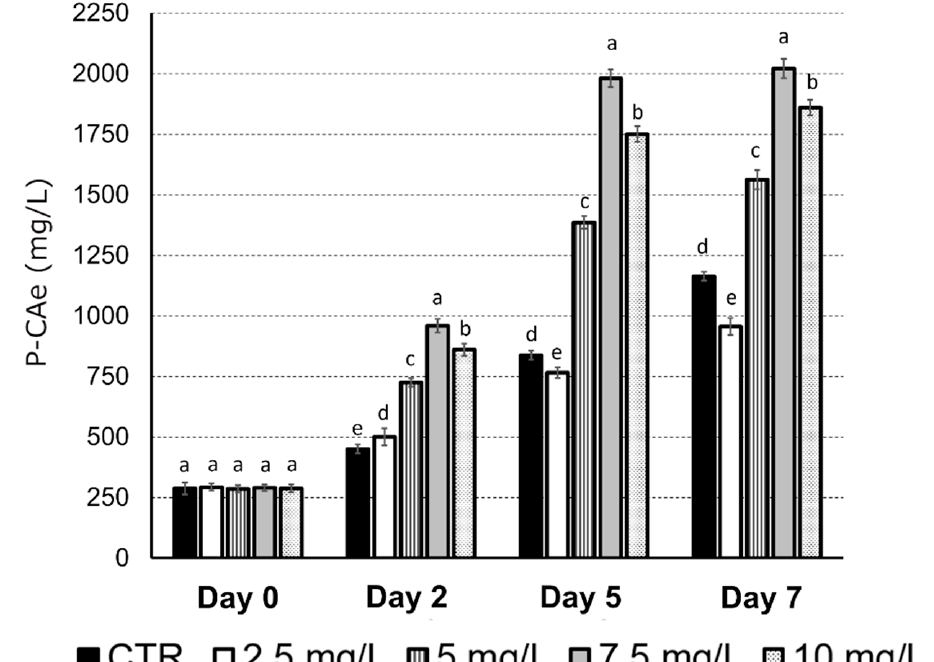
Figure 1. Content of total polyphenols, expressed as chicoric acid equivalent (P-CAe) after the addition of methyl jasmonate (MeJa) at different concentrations (2.5, 5, 7.5 and 10 mg/L) for 0, 2, 5 or 7 days. Data are mean ± SE for three biological replicates. Different letters above the bars indicate statistically significant differences at p < 0.05 for ANOVA.